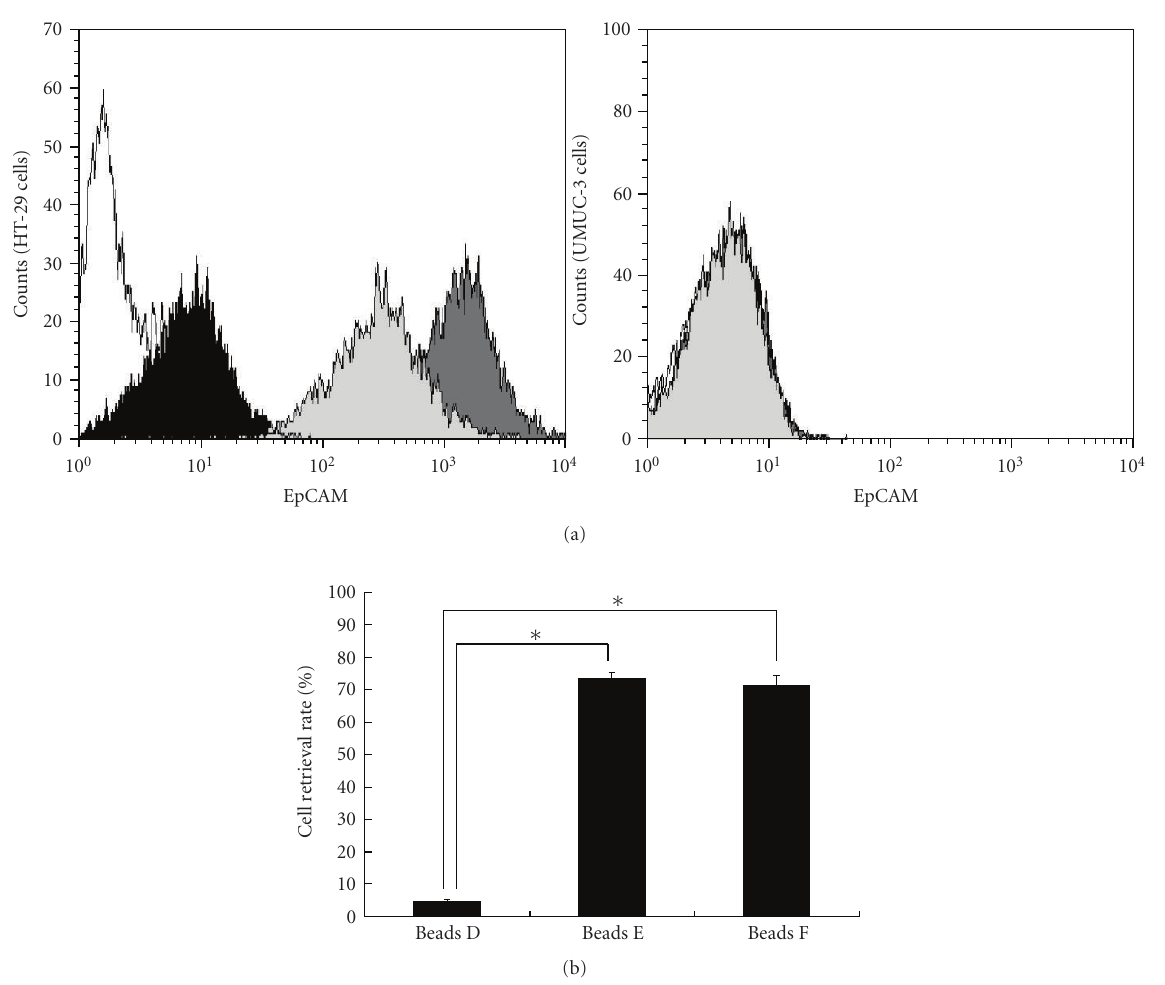
Figure 2: A simulation experiment for the recovery rates of colonocytes depending on the a ffi nity of mAbs. (a) The a ffi nities of newly developed antihuman EpCAM mAbs are analyzed using flow cytometry. HT-29 cells, which are positive for EpCAM antigen, and UMUC-3 cells, which are negative for EpCAM antigen, are used. The white peak, black peak, dark-gray peak, and light-gray peak show nonspecific mouse IgG1 mAb, clone 1-2, clone B8-4, and clone B8-7, respectively. (b) Simulation examining the recovery of the colonocytes. The cell recovery rates using beads D (tagged with a lower a ffi nity mAb, Clone 1-2), beads E (tagged with a higher a ffi nity mAb, Clone B8-4), and beads F (tagged with a higher a ffi nity mAb, Clone B8-7) are 4.5 ± 0.98 (%, mean ± SD), 73.5 ± 1.96, and 71.2 ± 3.39, respectively. The columns show the cell retrieval rates and the bars show the standard deviations. Significant di ff erences are showed by an asterisk ( ∗ , P <